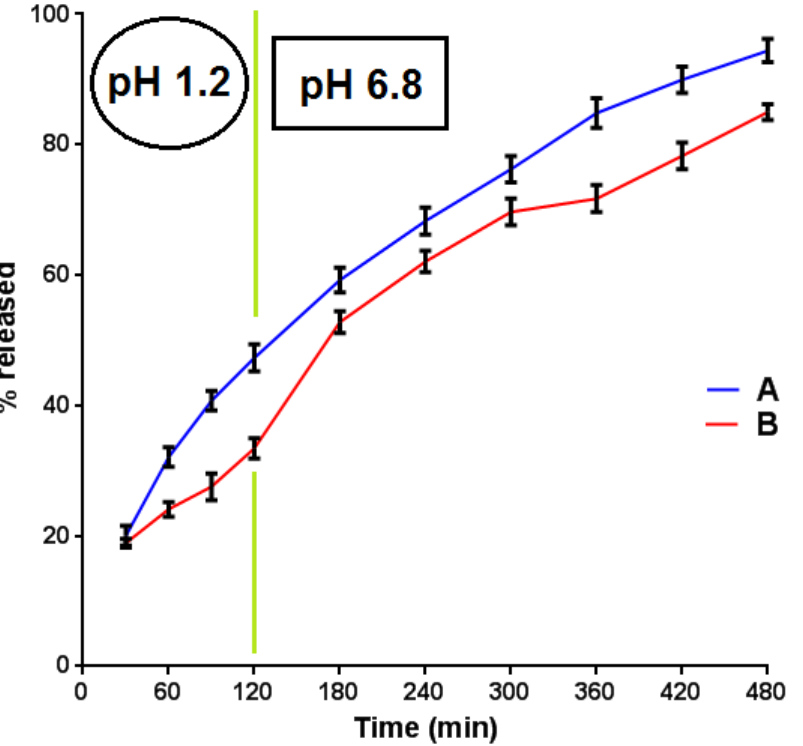
Figure 6. In vitro % release (mean values, N = 3) of NTX·HCl from formulations A and B vs. time.